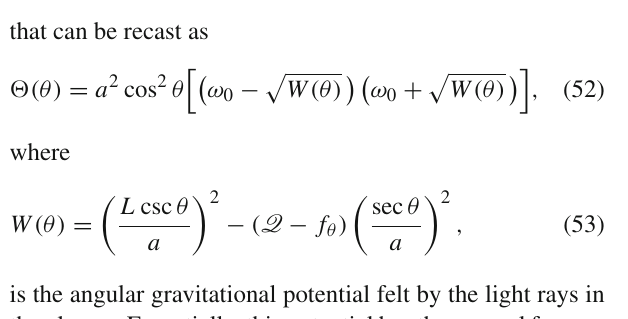
that can be recast